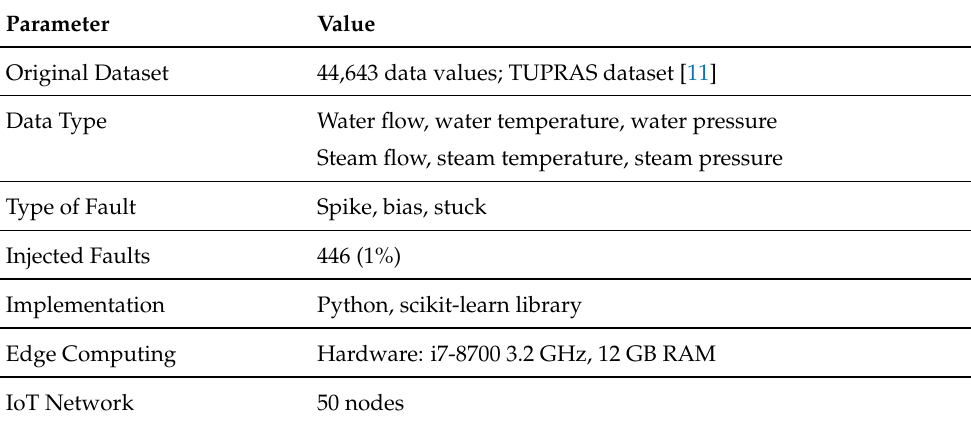
Table 1. Parameters and